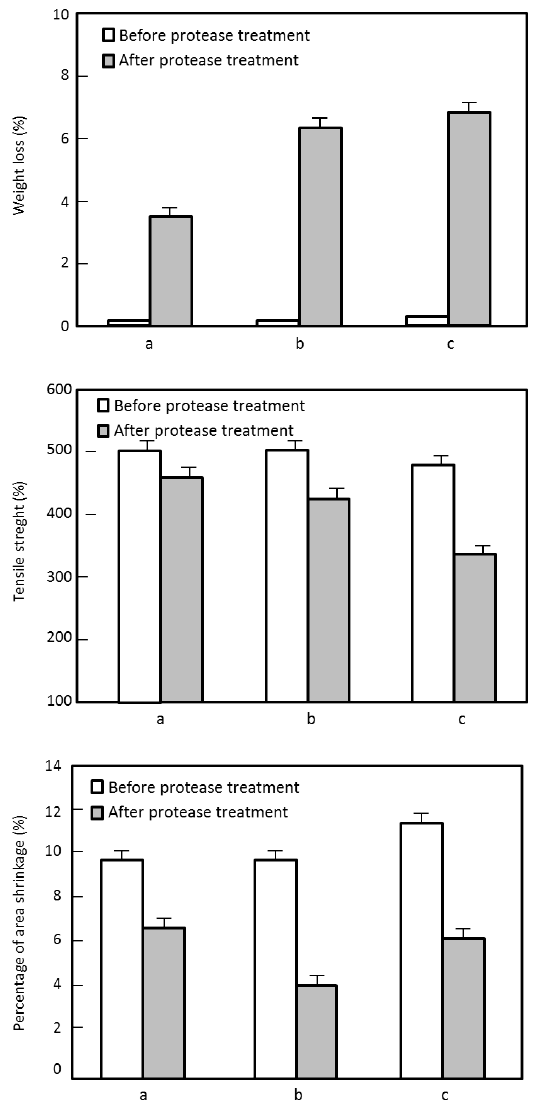
Figure 4. Loss of weight, breaking stress and shrinkage area for wool fabrics before (white bars) and after (gray bars). (a) control; (b) pretreated with cutinase; (c) pretreated with hydrogen peroxide. Adapted from